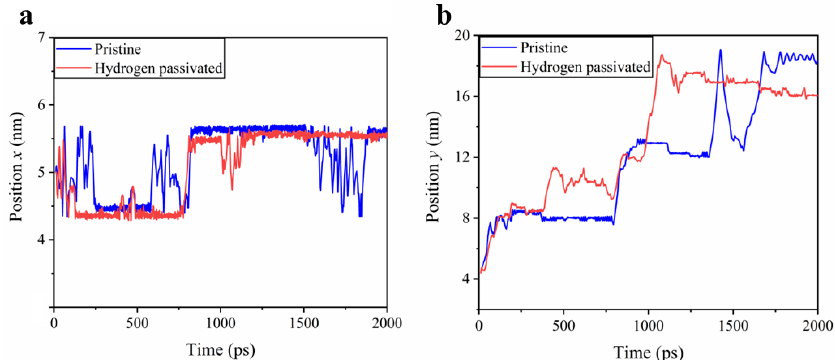
Figure 4. The movement of pristine and hydrogen-passivated graphene nanoflakes. ( a ) Along x direction. ( b ) Along y direction.